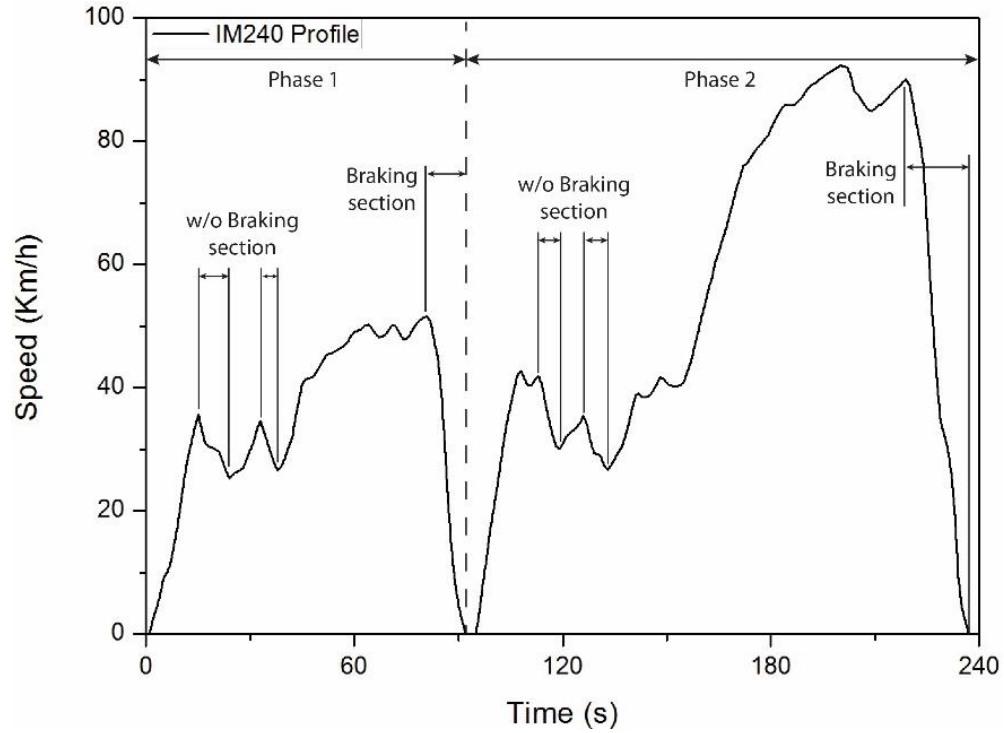
Figure 4. Driving profile of IM240 mode.